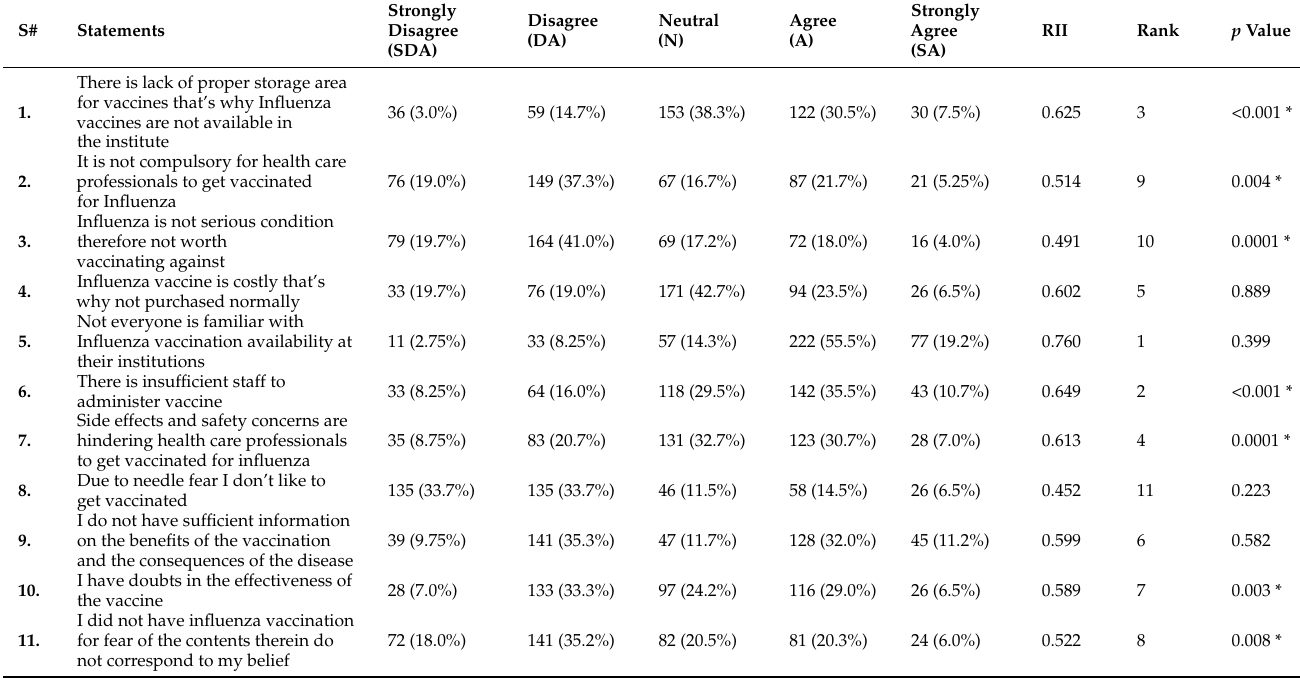
Table A2. Barriers to influenza